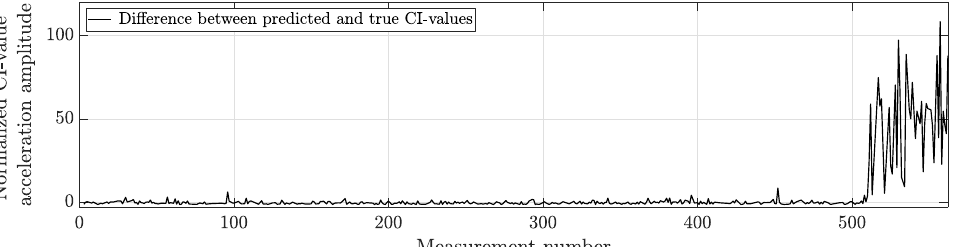
Figure 6. Gearbox output shaft bearing failure case 1, enveloped WPT CI-values. Comparison of ANN’s predicted CI-values in red and true CI-values in blue at the top graph in ( a ) and normalized difference between them at the bottom graph without rotational speed variance data filtration. Normalized difference between predicted and true CI-values with rotational speed variance data filtration in ( b